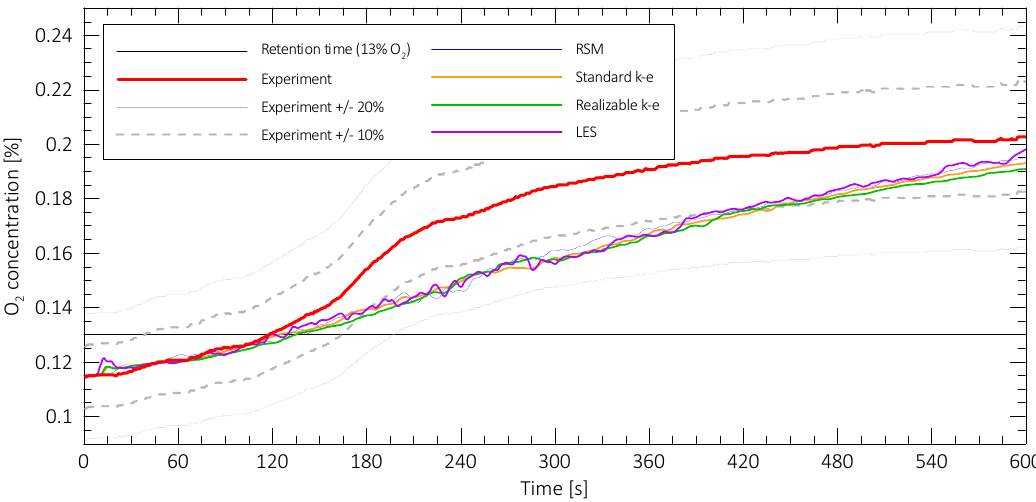
Figure 6. Changes in oxygen concentration (v/v) on the probe No. 5, indicating the end of the retention time during experimental tests and CFD simulations, fire-extinguishing gas Ar 0% v/v and N 2 100% v/v.